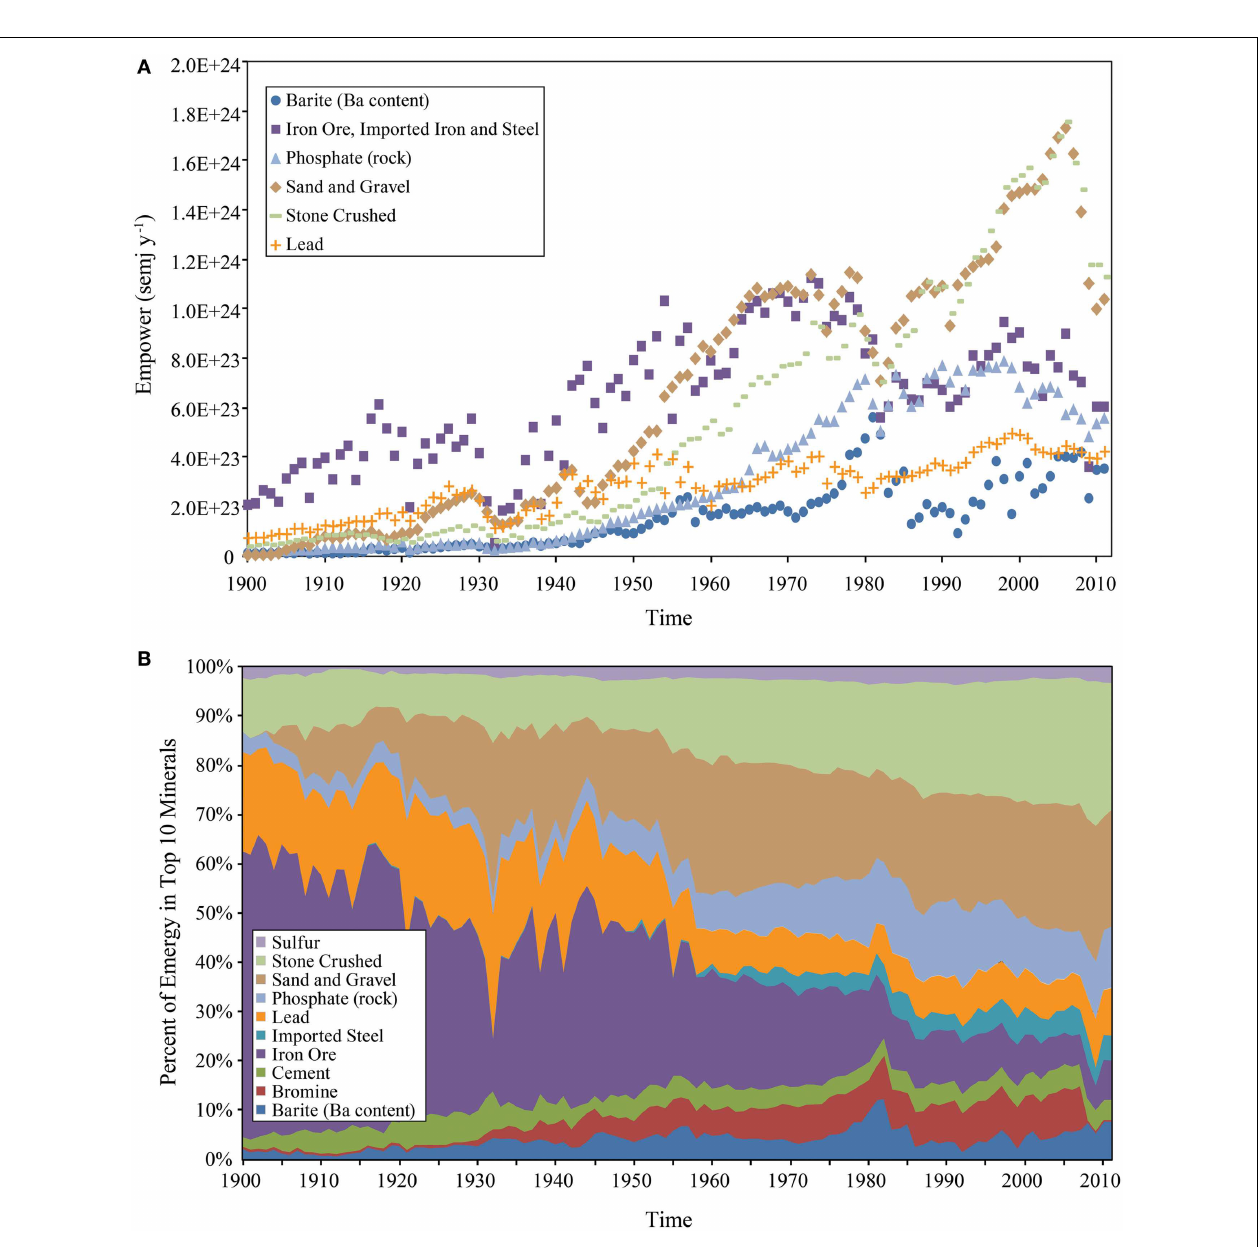
FIGURE 7 | Emergy of some minerals consumed in the U.S. Economy from 1900 to 2011 is shown . (A) Temporal patterns of the six minerals contributing the largest amount of emergy to the U.S. (B) structure of the top 10 minerals shown as percent composition.